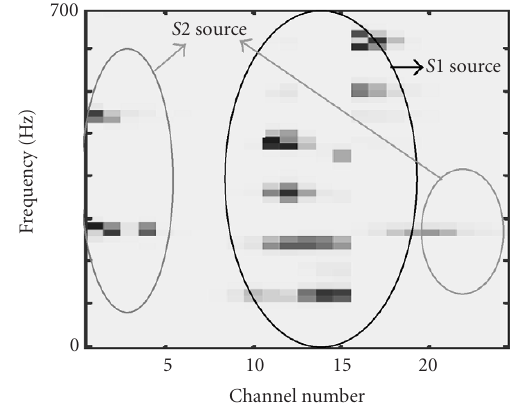
Figure 3: Example of a 24-channel CAM for a mixture of /di/ and /da/ pronounced by two speakers; mixture at SNR = 0dB and frame center at t = 166milliseconds.